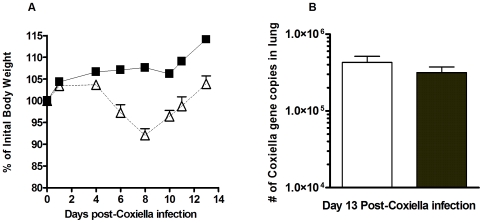
Resolution of a Coxiella burnetii infection in PCN-treated mice.A) PCN-treated mice (▪) gained body weight following C. burnetii infection whereas PBS-treated control mice (Δ) initially lost weight but were able to recover by 2 weeks post-infection. B) No difference in the rate of clearance of the C. burnetii infection from the lungs of the PCN-treated (shaded bar) and PBS-treated (clear bar) mice was detected.